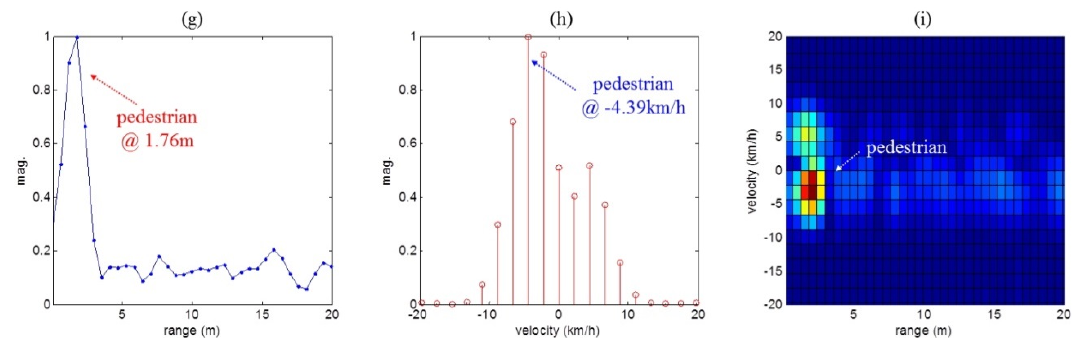
Figure 9. Measurement results using the conventional method and the proposed detection method for scenario (ii). Here, ( a – c ) present the results of the typical method using windowing; ( d ) indicates the results of the typical method without windowing; ( e , f ) show the results of removing the zero Doppler components in the typical method; and ( g – i ) are the results of the proposed method.